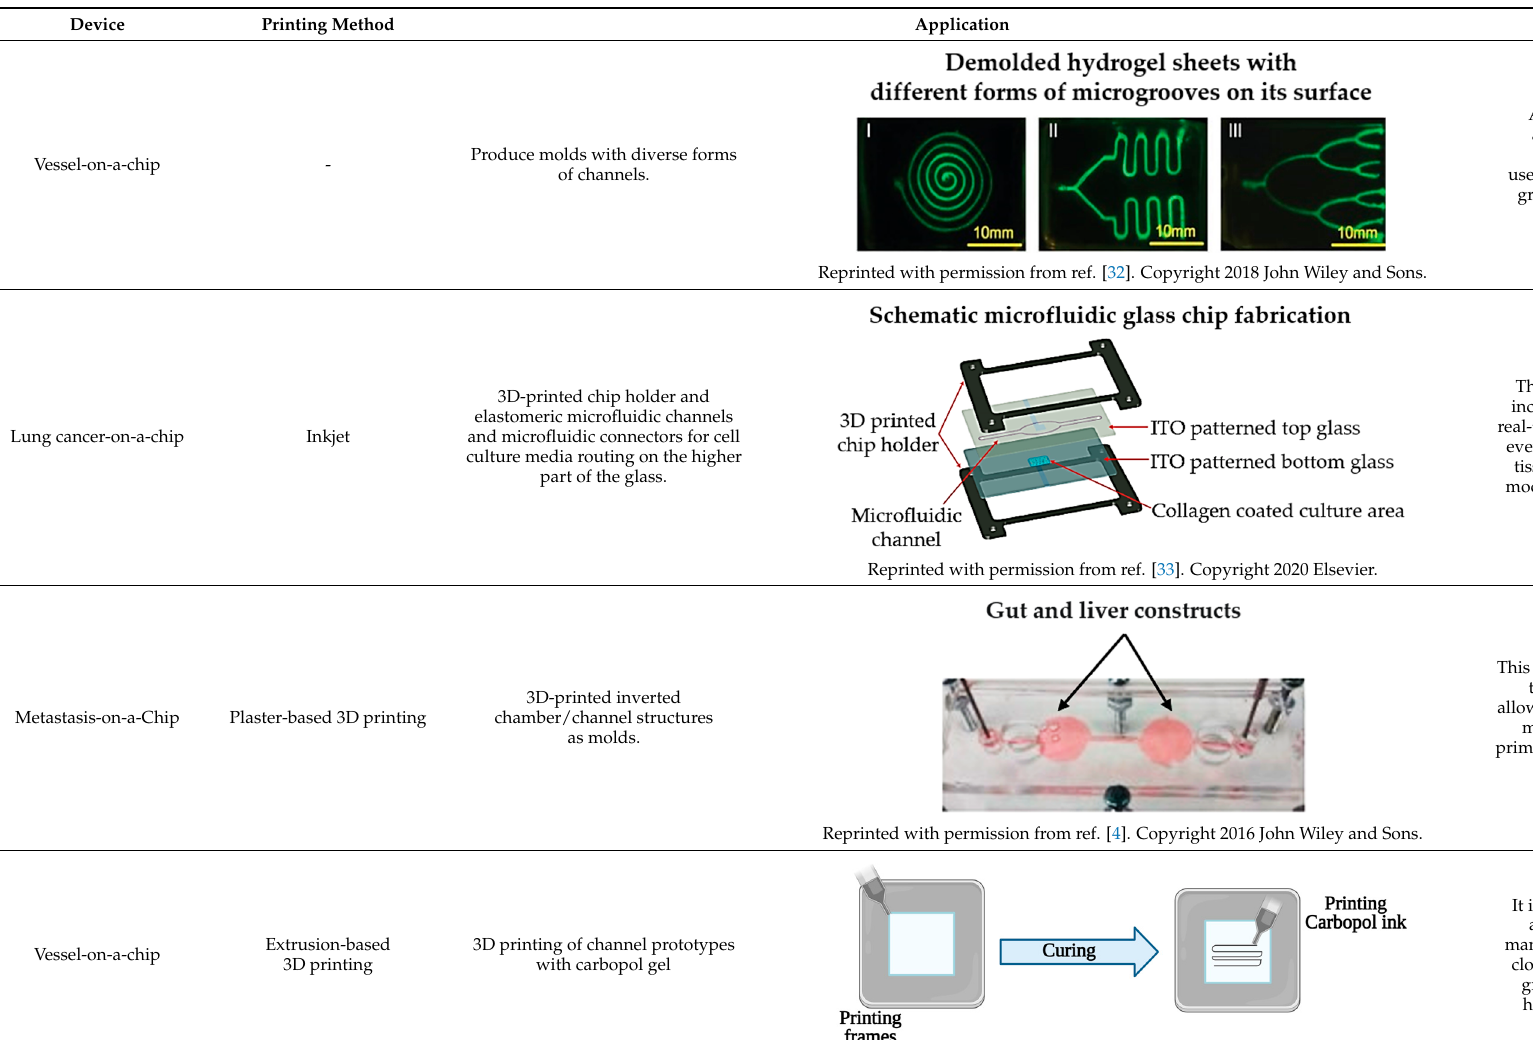
Table 1. 3D printing techniques used to fabricate OoC platforms.